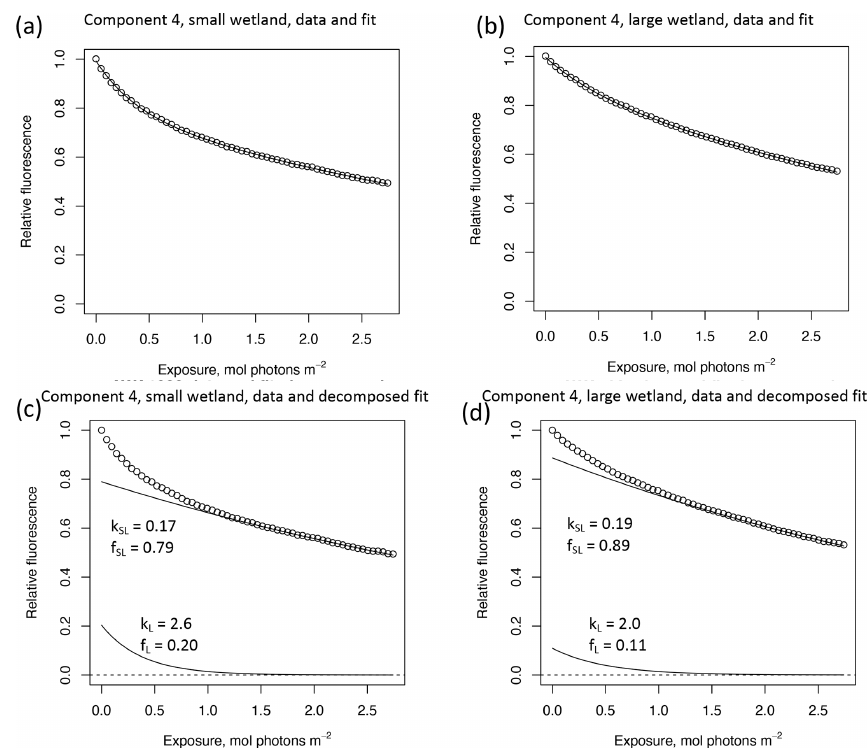
Figure A3. Data and model fit of PARAFAC component four loss in experiments with two wetland samples. Panels (a, b) show data and model fit (Eq. 3), while panels (c, d) decompose the fitted model into its two summed terms, f L e − k L P and f SL e − k SL P , or labile and semilabile terms. (a) Data and fit for the small wetland, (b) data and fit for the large wetland, (c) data and decomposed model for the small wetland, and (d) data and decomposed model for the large wetland.